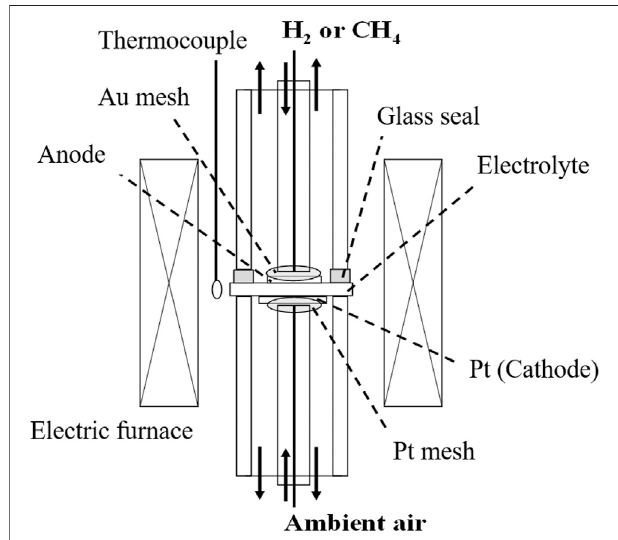
FIGURE 1 | Schematic picture of the con fi guration of the cell test under H 2 and CH 2